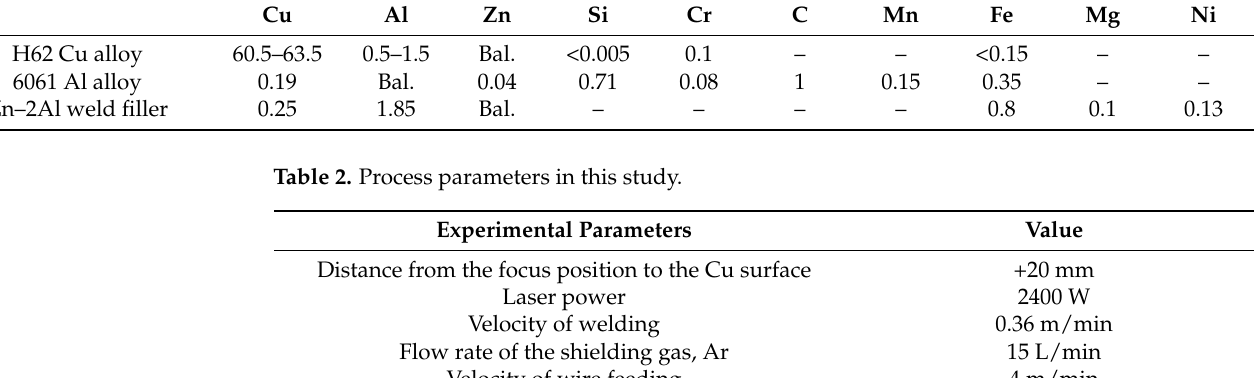
Table 1. Chemical compositions of the base metals and the Zn-based filler (wt.%) [7,36]. Cu